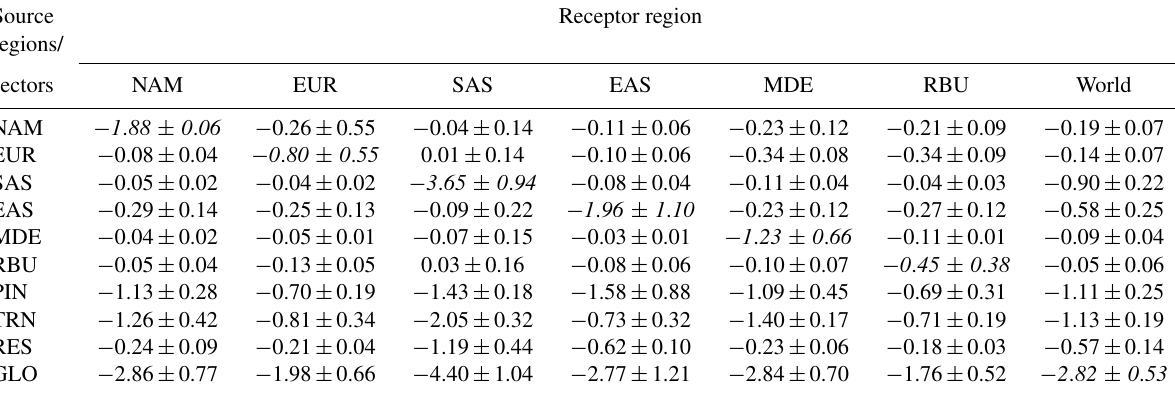
Table 2. Population-weighted multi-model mean change in O 3 (ppb) in receptor regions due to 20% regional (NAM, EUR, SAS, MDE, and RBU), sectoral (PIN, TRN, and RES), and global (GLO) anthropogenic emission reductions, for the 6-month O 3 season average of 1h daily maximum. The diagonal, showing the effect of each region on itself, is shown in italics. All numbers are rounded to the nearest hundredth, and are shown with standard deviations among